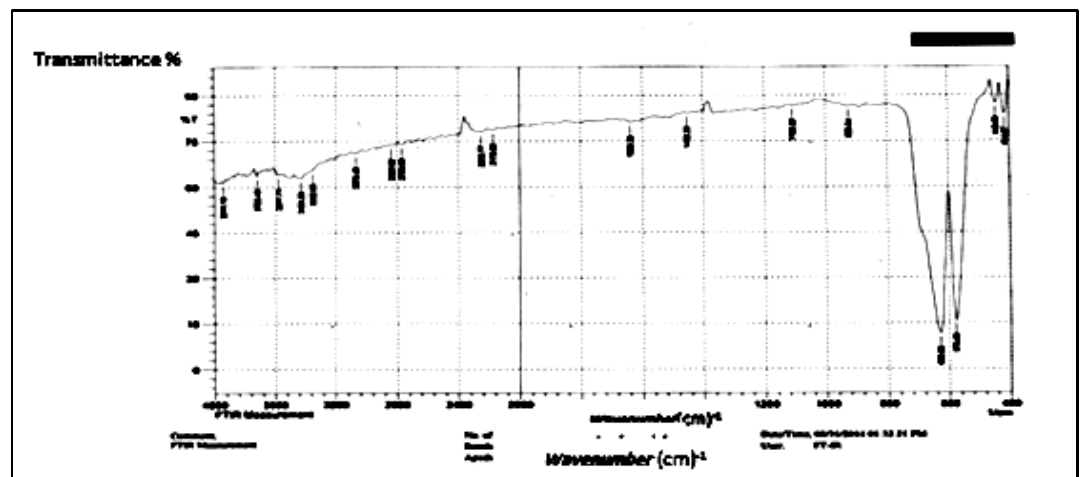
Figure 3: FTIR spectrum of the nano-sizedCr2O3 prepared by SP technique.